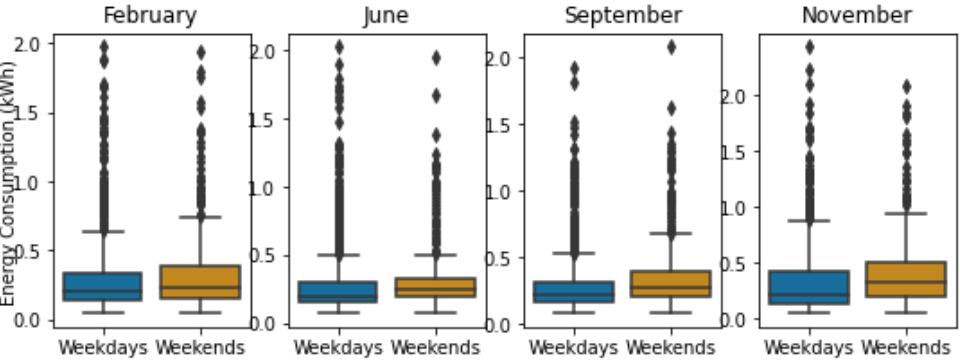
Figure 8. Distribution of energy consumption based on type of day (1 month from each